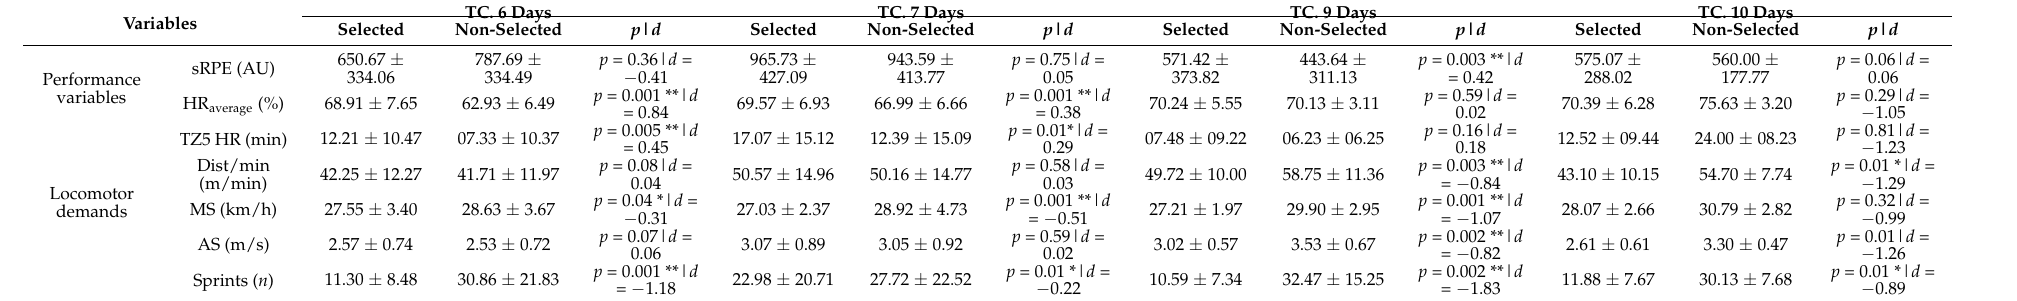
Table 4. Performance variables (sRPE, HR average , VO2 max , and TZ5 HR) and locomotor demands (dis/min, maximal speed, average speed, and sprint